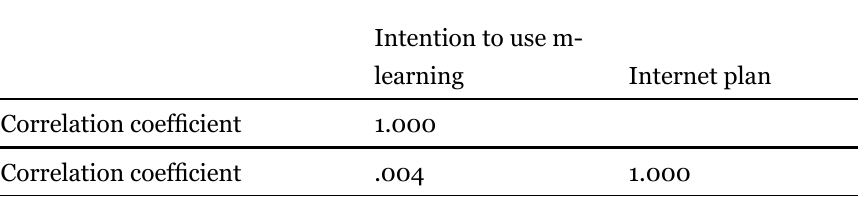
Correlation between Internet Plan and Intention to use M-Learning